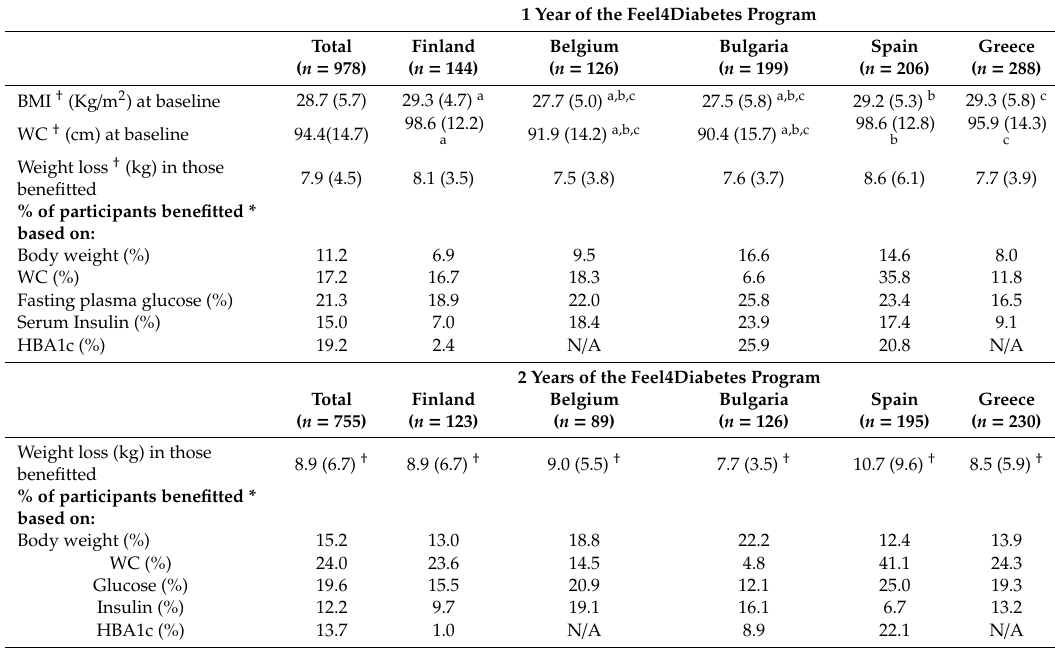
Table 2. Mean anthropometric values at baseline, mean weight loss and percentages of participants (%) benefitting from the Feel4Diabeets program in the total sample, by country and duration of the program. 1 Year of the Feel4Diabetes